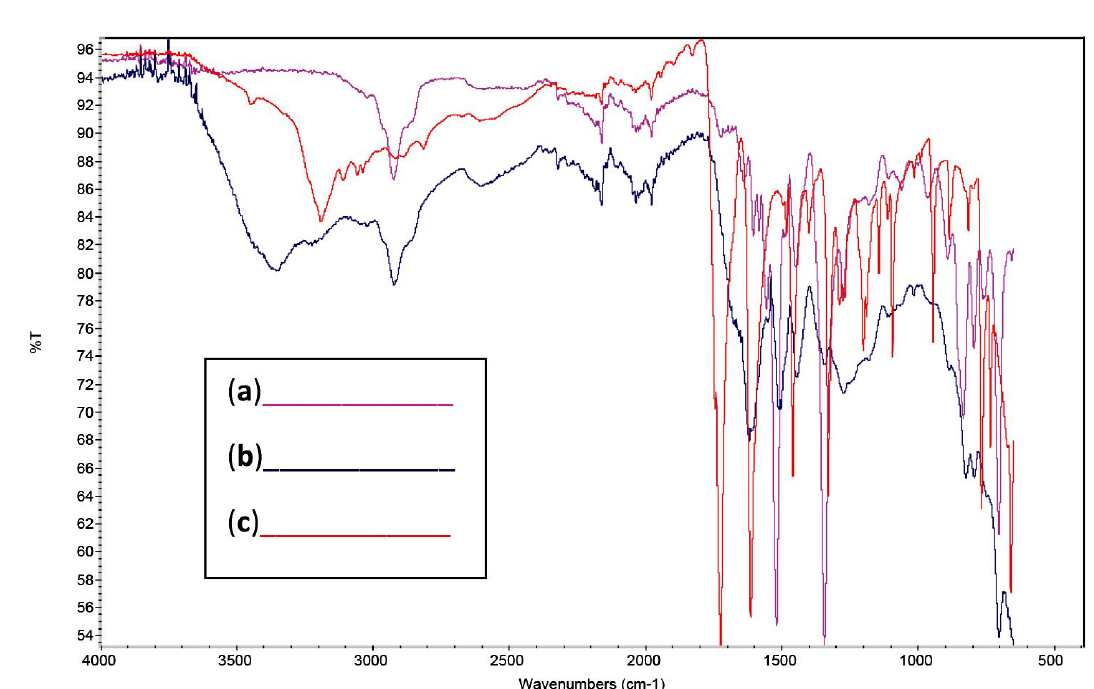
Figure 2. FT-IR Spectra of ( a ) Nitro-Amberlite XAD-2 ( b ) Amino- Amberlite XAD-2 ( c ) Isatin based Amberlite